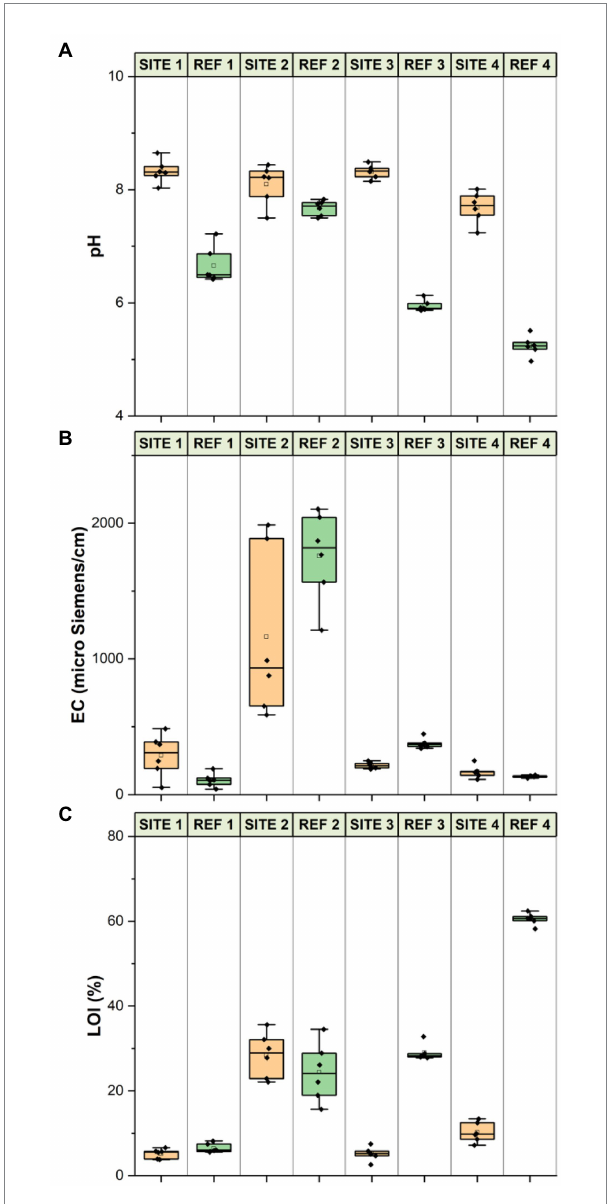
FIGURE 2 Distribution of sediment pH (A) , sediment electrical conductivity (B) and sediment Loss on Ignition (C) between underpass sites (orange) and respective reference sites (green). Data show raw data points as dots, with 95 th percentile, interquartile range and median shown by